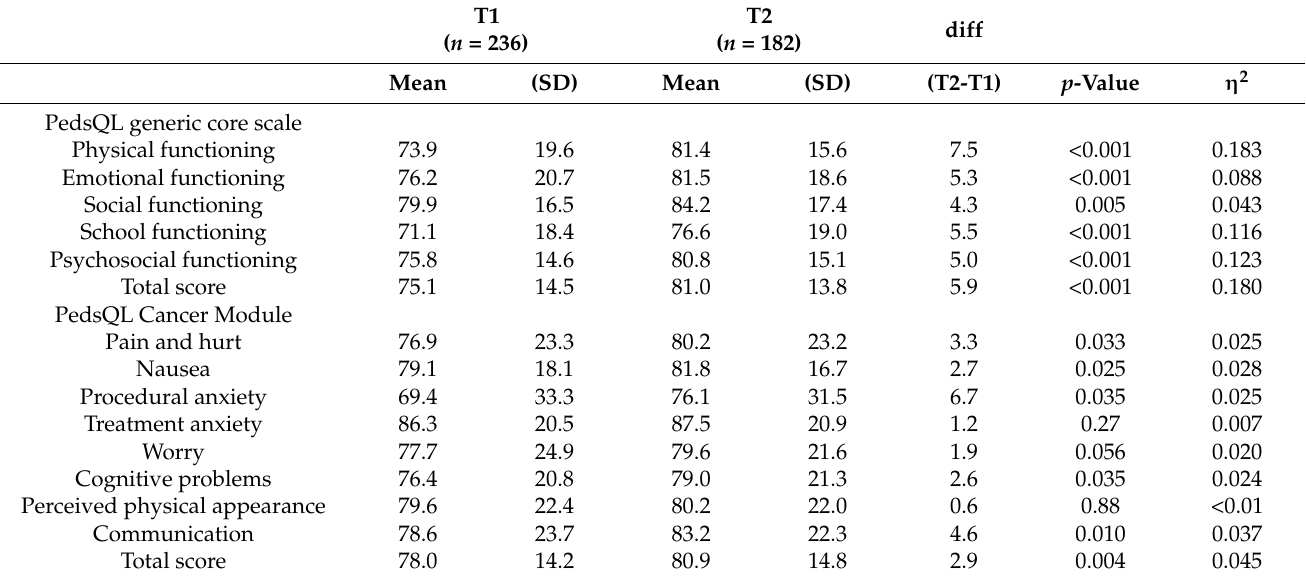
Table 3. Self-reported quality of life before and after rehabilitation (child report). T1 ( n = 236)